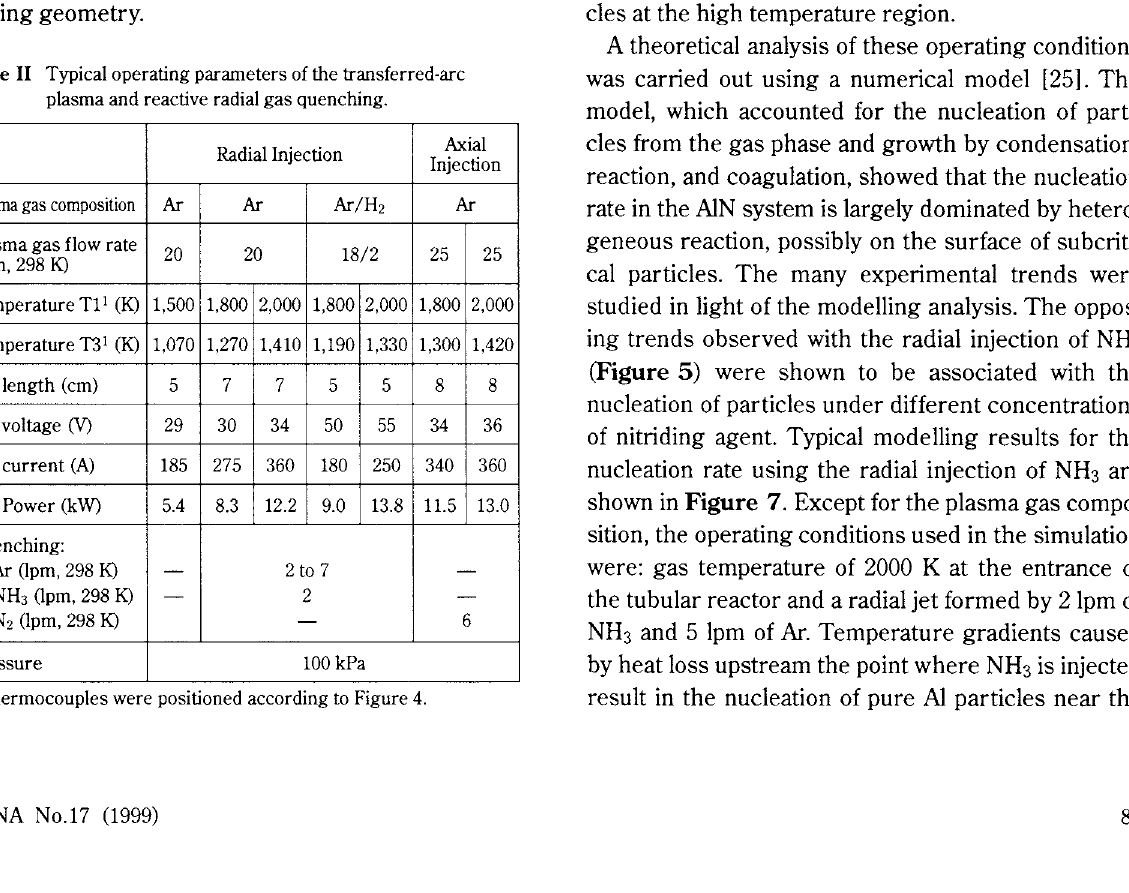
Table II Typical operating parameters of the transferred-arc plasma and reactive radial gas quenching.